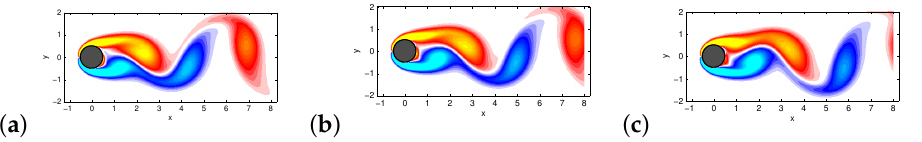
Figure 4. Some vorticity field snapshots for the wake behind a cylinder at Re = 100 are shown in ( a – c